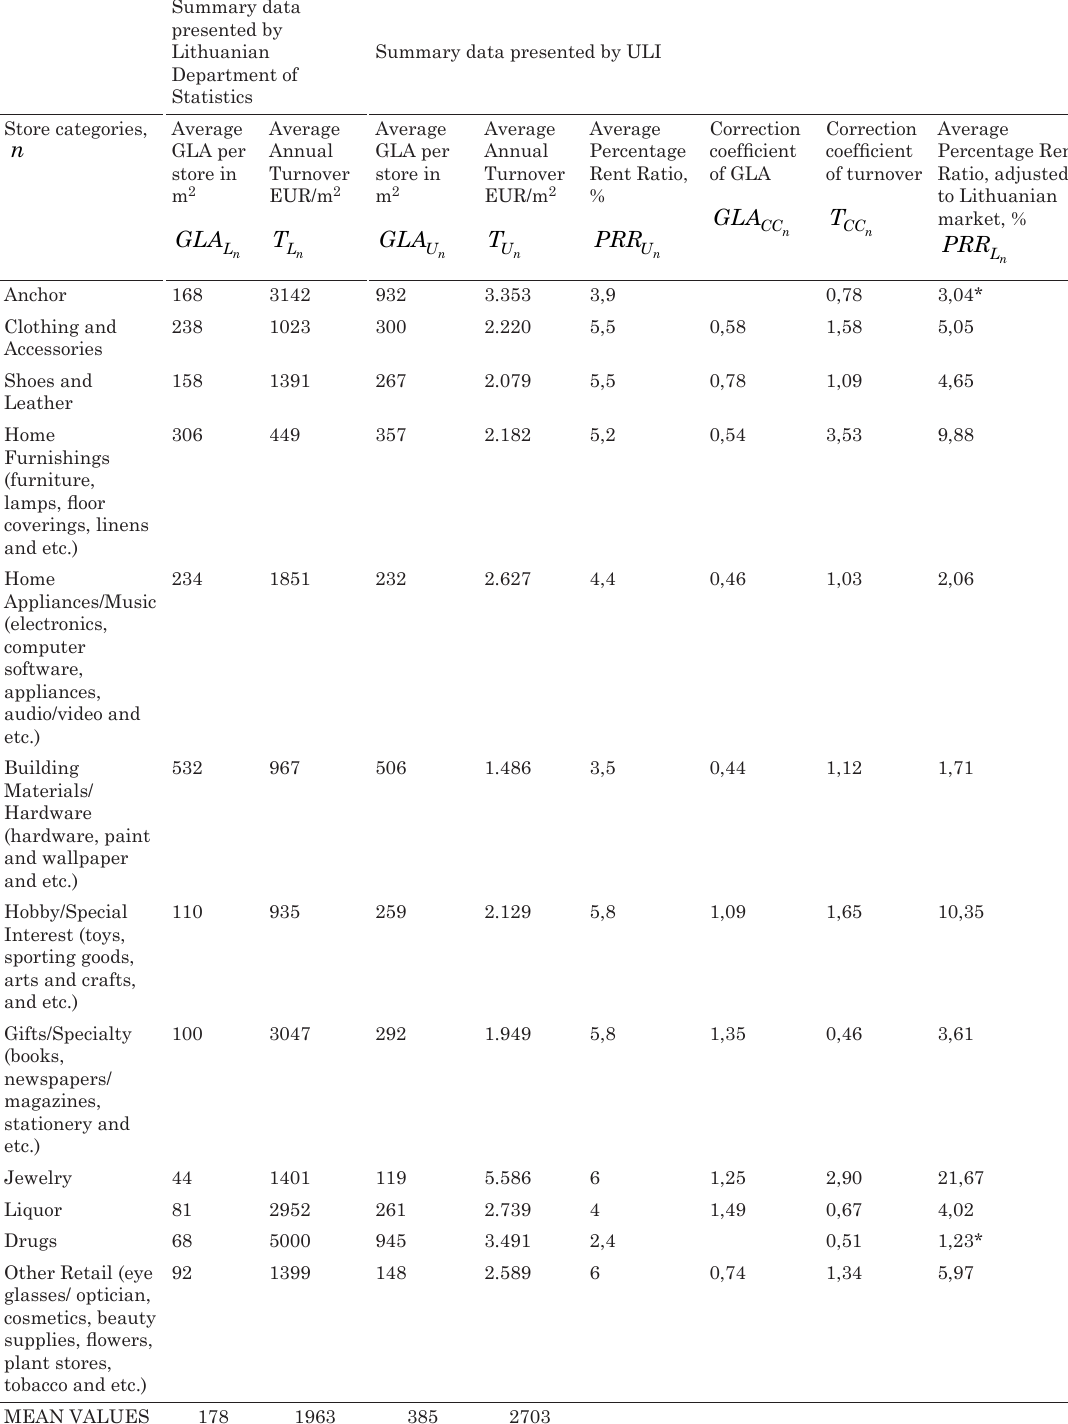
Table 3 . Determination of Percentage Rent Ratio ( Retail ..., 2005–2011; ULI – the Urban Land Institute,